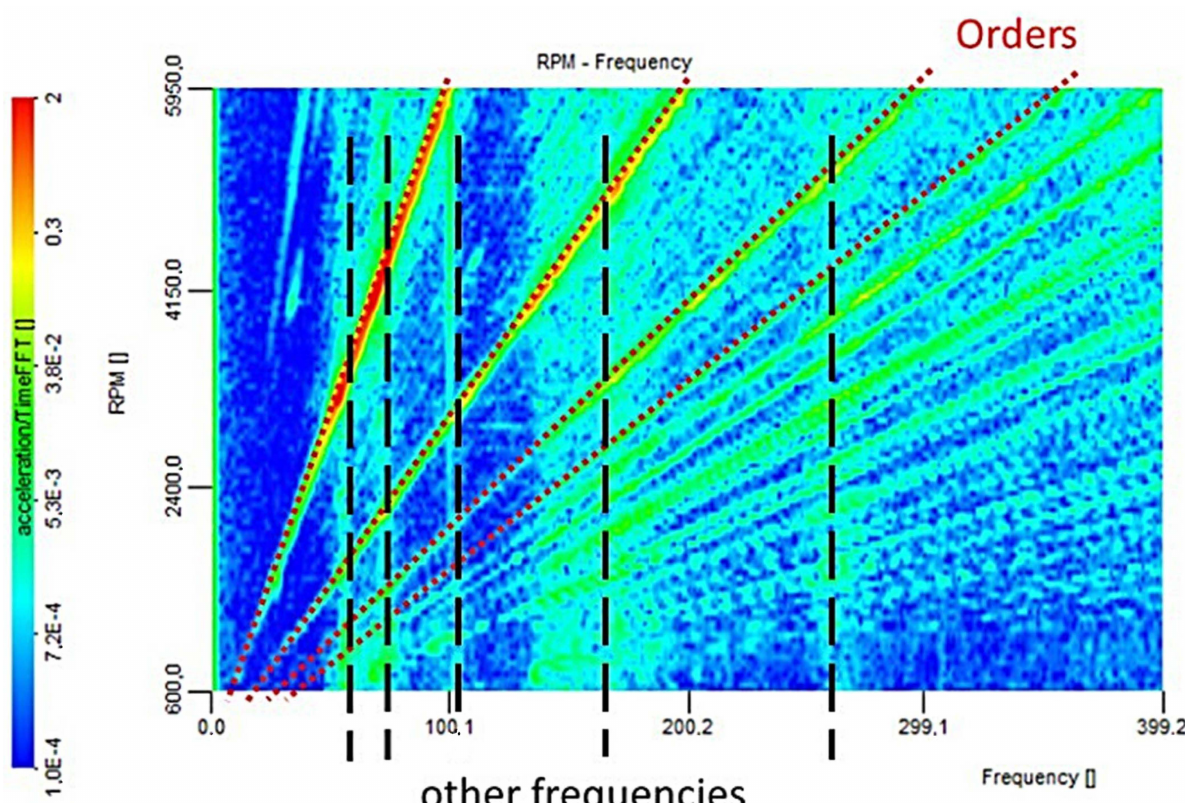
Figure 7. A time–frequency graph with the orders related to the change of speed and other character- istic frequencies